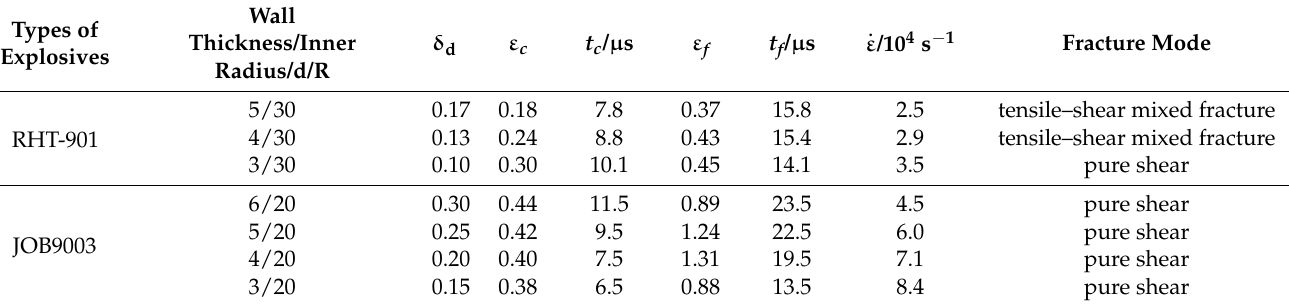
Table 1. Experimental cylindrical shell, loading conditions, and explosion–expansion fracture phe- nomenon, Refs.